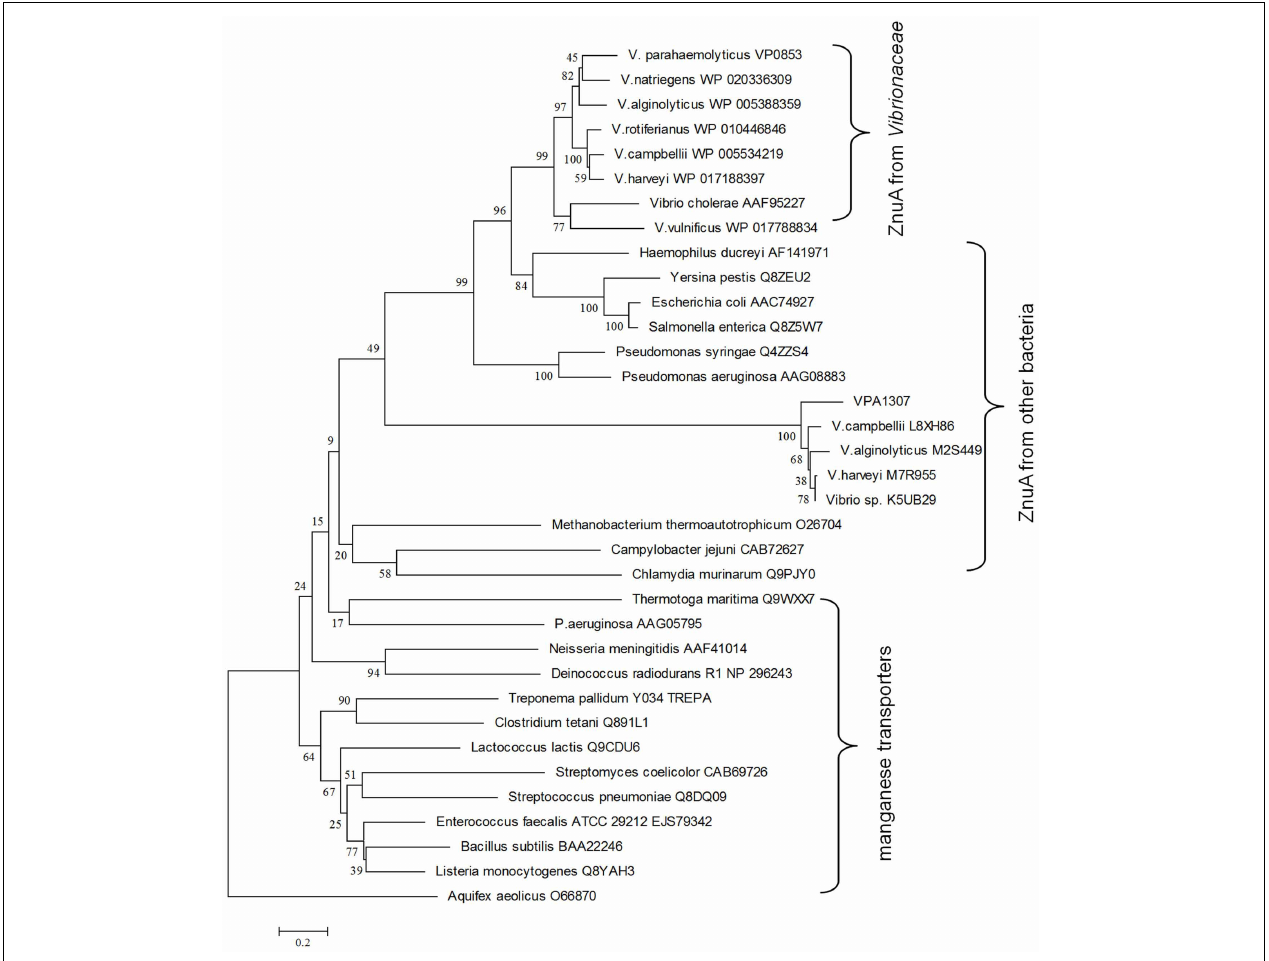
FIGURE 4 | Neighbor-joining tree of VPA1307 and related genes. The protein sequences were obtained from NCBI except that L8XH86, M2S449, M7R955, and K5UB29 were obtained from EBI. ZnuA homologs were represented in red (except that of Aquifex aeolicus ) and